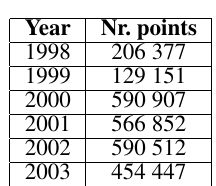
Table 1. Number of input points per yearly epoch for